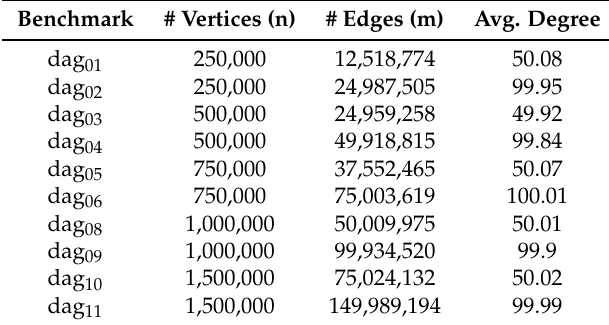
Table 2. The home-made graph